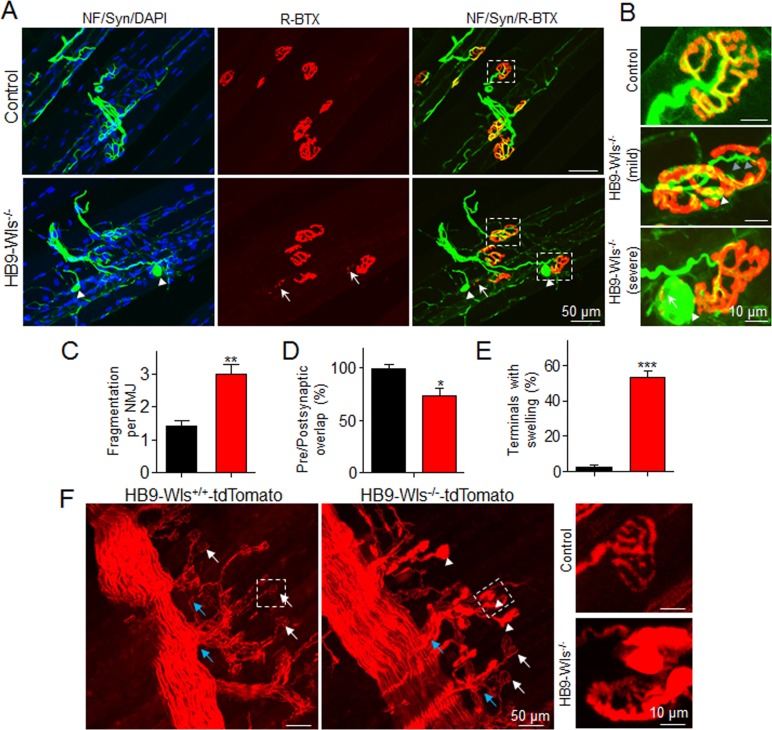
Abnormal pre- and postsynaptic NMJ structure in HB9-Wls-/- mutant mice.(A) Immunostaining of NMJs in gastrocnemius of 2-month-old control and HB9-Wls-/- mice with anti-NF/anti-Syn (Green) and R-BTX (Red). Nuclei were labeled with DAPI (Blue). In mutant, some nerve terminals are swollen (white arrowhead) and AChR clusters are broken (white arrow). (B) The high magnification of boxed area in A. White arrowhead indicates swollen nerve terminals. Blue arrowhead indicates motor nerve detaching from AChR clusters; White arrow indicates broken pieces of AChR. (C) Statistical results of AChR fragmentation per NMJ. n = 3 mice per group; Unpaired t-test, **p<0.01. (D) Percentage of AChR cluster innervated with nerve terminals. n = 3 mice per group; Unpaired t-test, *p<0.05. (E) Percentage of nerve terminal swellings. n = 3 mice per group; Unpaired t-test, ***p<0.001. (F) The diaphragm of 2-month-old HB9-tdTomato and HB9-WLS-/- tdTomato mice. Nerve terminal swellings are indicated with white arrowhead. Normal nerve terminals are indicated with white arrow. Axon branch are indicated with blue arrow. Boxes indicated by dash line were enlarged in the right.